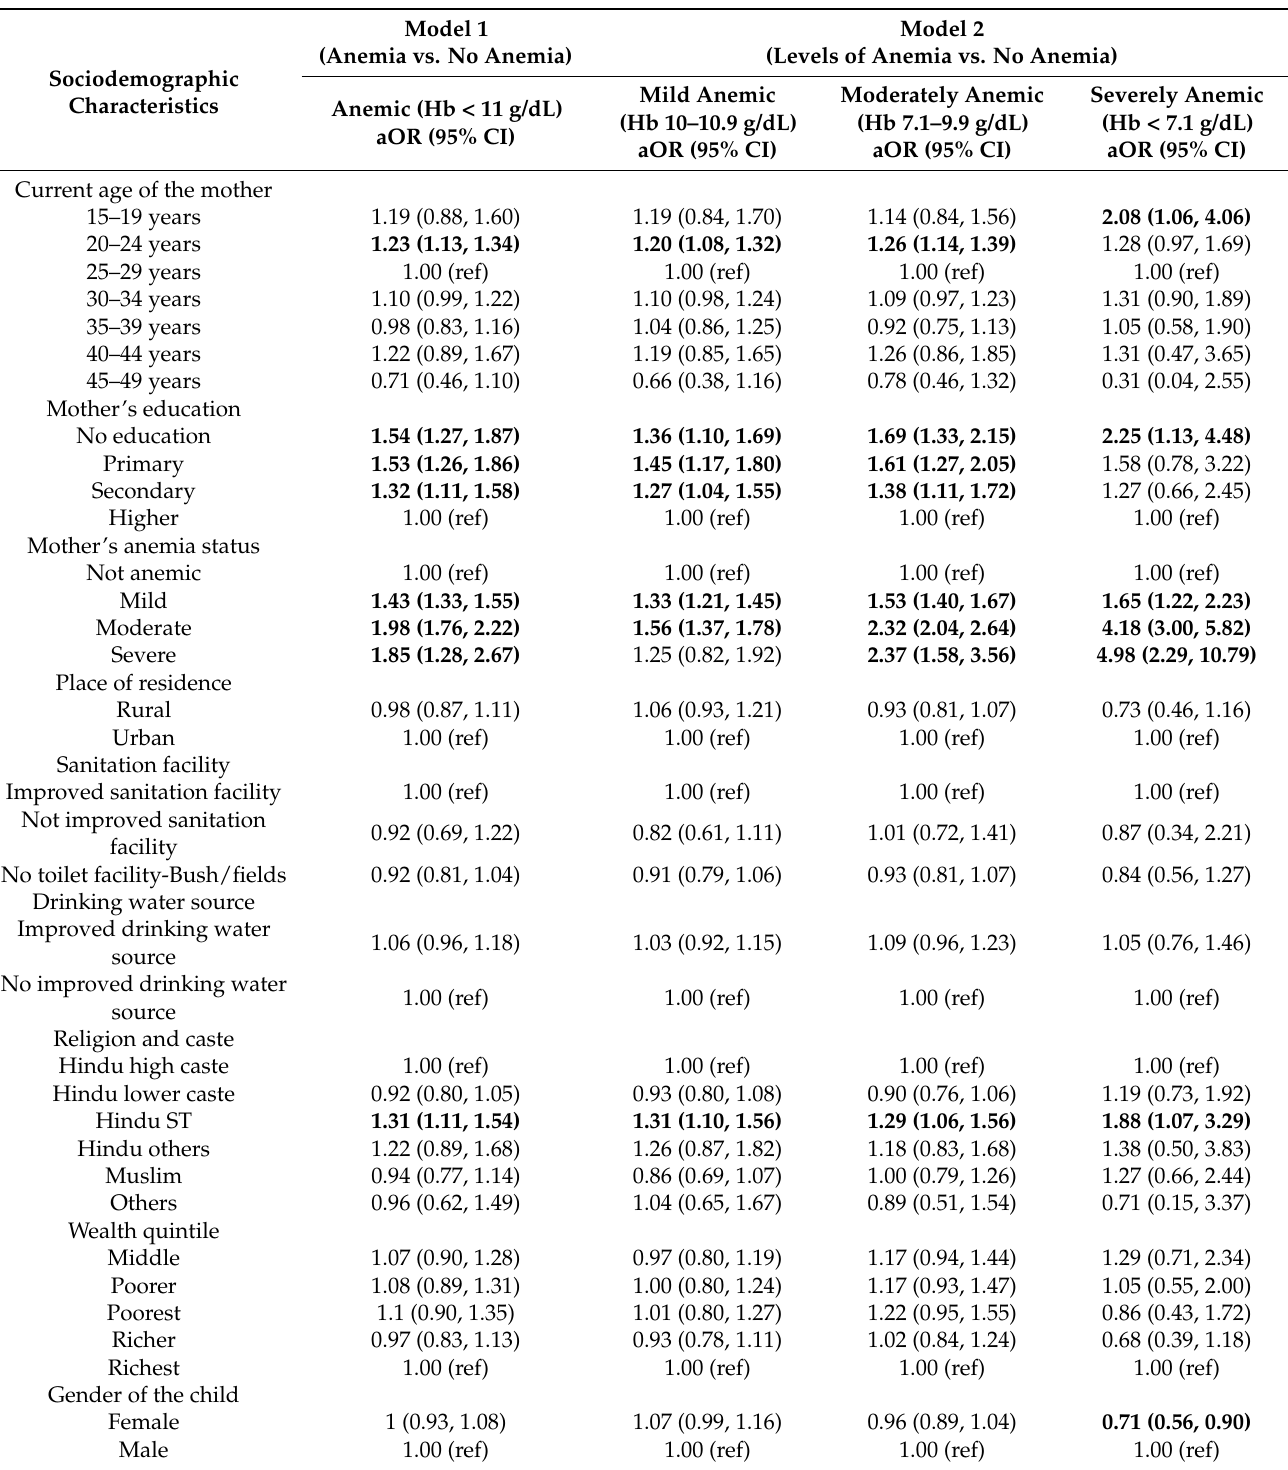
Table 3. Adjusted odds ratios (aORs) of the weighted analyses representing association of anemia in children and sociode- mographic characteristics (Model 1: Presence of anemia, Model 2: Level of